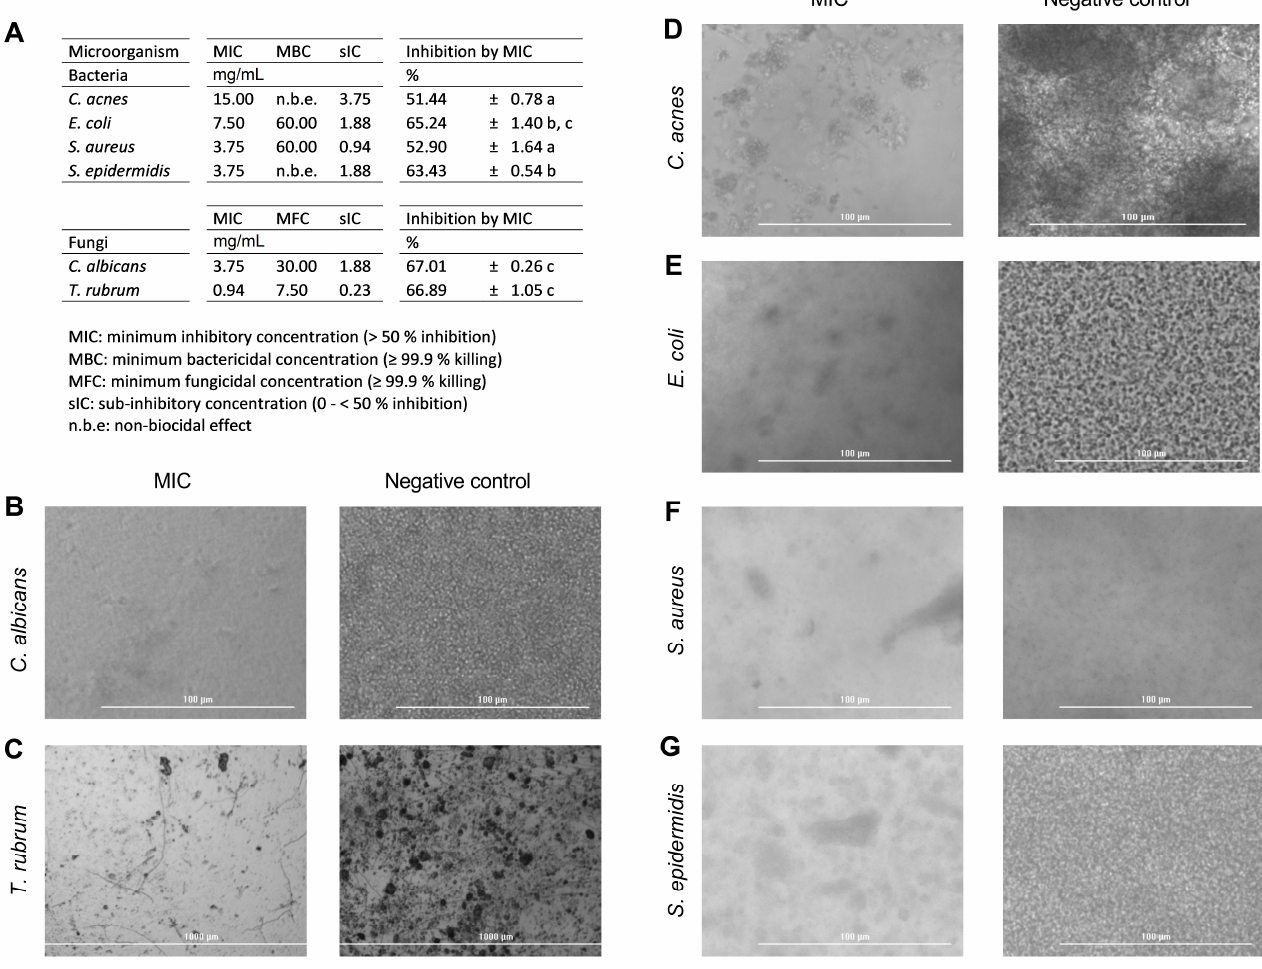
Figure 4. ( A ) Minimum inhibitory (MIC), biocidal (MBC), and sub-inhibitory (sIC) concentrations of persimmon extract rich in carotenoids (PEC) by microdilution assay. MIC values of PEC led to a significant inhibition of microbial strains in comparison with untreated controls (different letters showed significant differences between tested strains, p < 0.05, ANOVA and Tukey’s post hoc test). Optical images of wells containing PEC MIC-treated live microorganisms (left) or untreated controls (right): ( B ) Candida albicans , ( C ) Trichophyton rubrum , ( D ) Cutibacterium acnes , ( E ) Escherichia coli , ( F ) Staphylococcus aureus , and ( G ) Staphylococcus epidermidis .